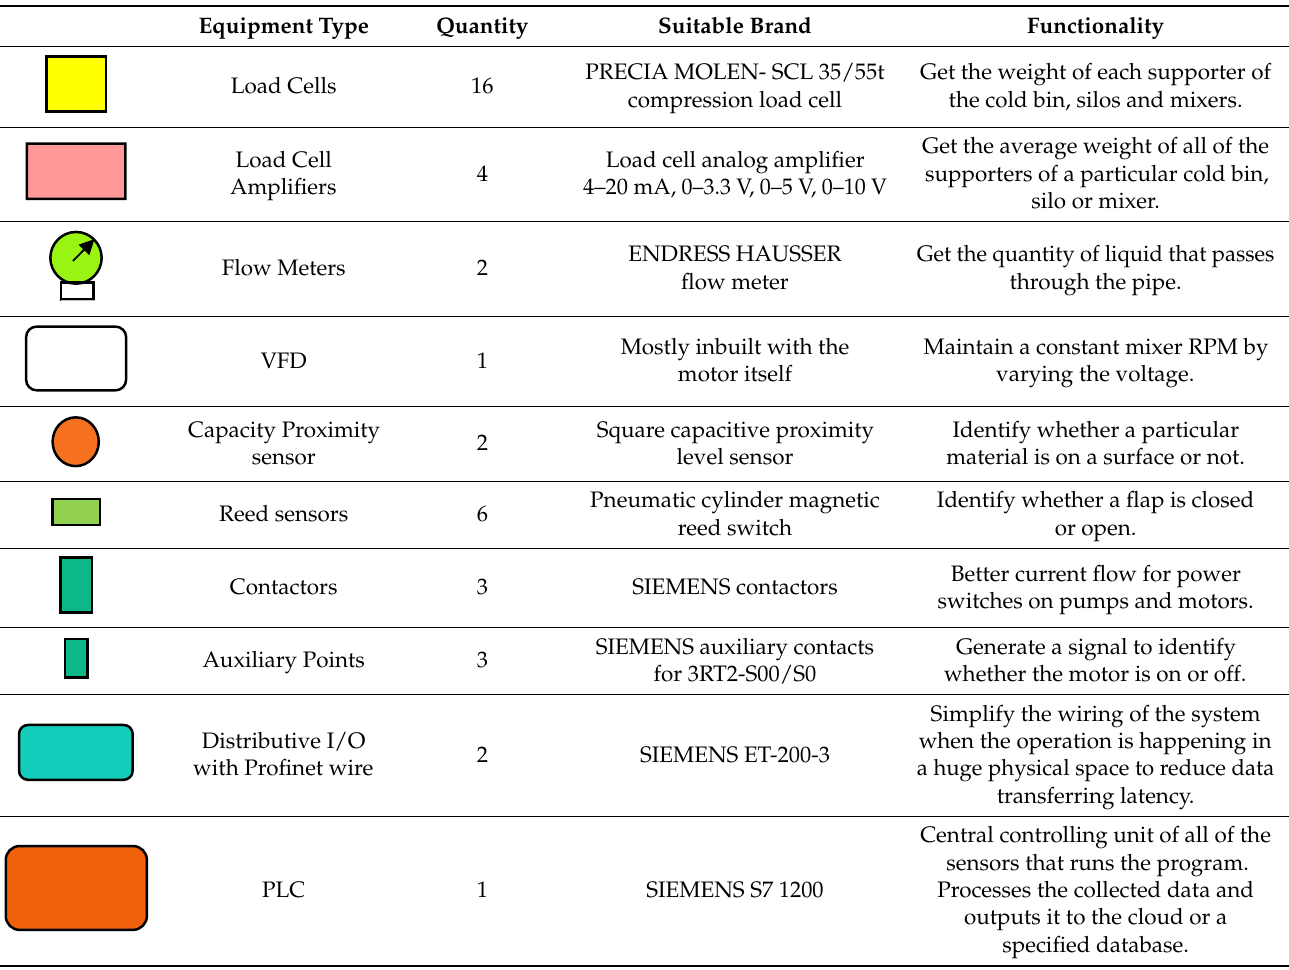
Table 4. IoT System Development Sensor Requirement Analysis.